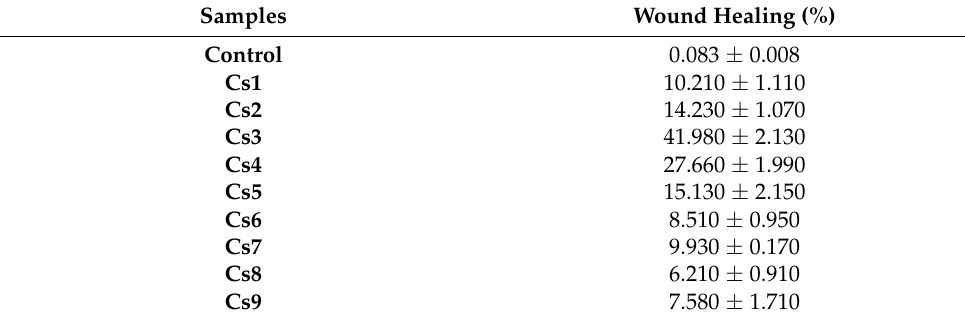
Table 10. Relative percentage of cells that migrated into the wound (%).